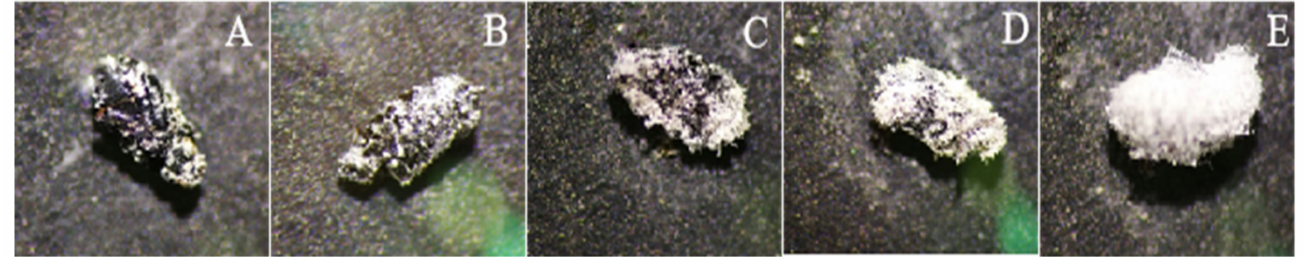
Figure 9. Mycelial growth of Phyllotreta striolata infected by I. javanica. ( A ) 3 d; ( B ) 4 d; ( C ) 5 d; ( D ) 6 d; ( E ) 7